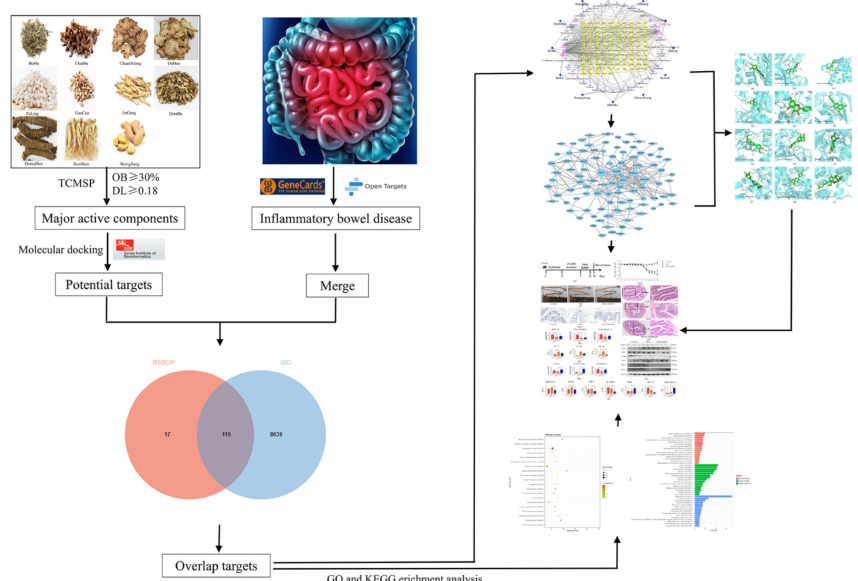
Figure 1. The technology roadmap of network pharmacology in this